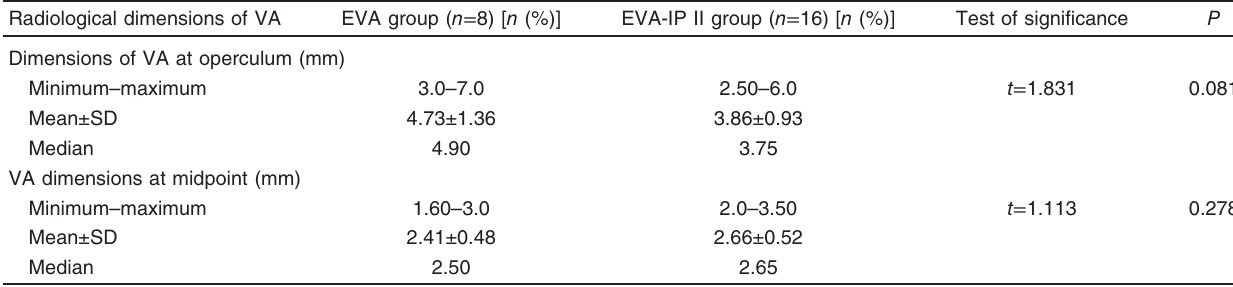
Table 2 Radiological dimensions of VA in both EVA and EVA-IP II groups Radiological dimensions of VA